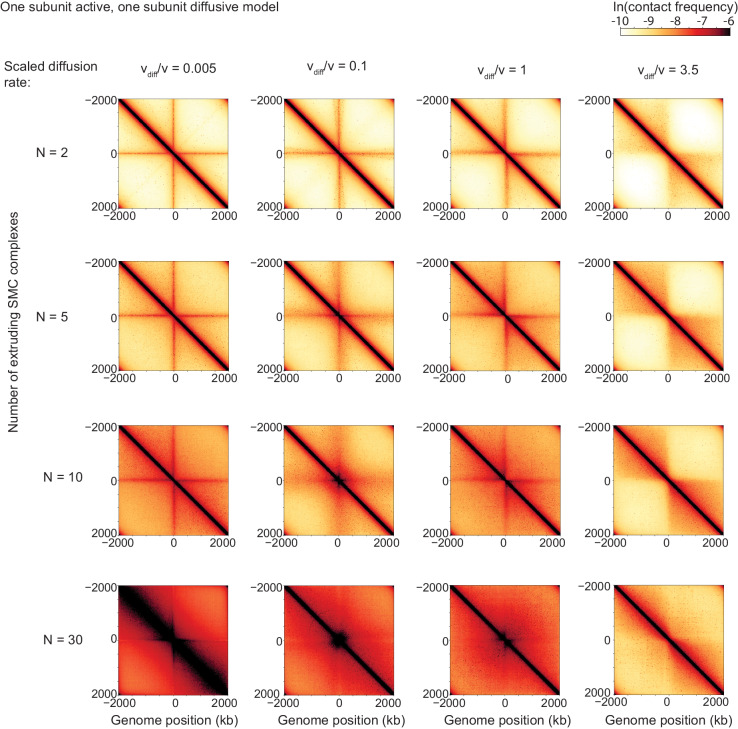
Sweep of the diffusive stepping rate and the number of LEFs for bacterial chromosomes.Scaled diffusive stepping rate increases from left to right, and number of LEFs (i.e. extruding SMC complexes) increases from top to bottom.